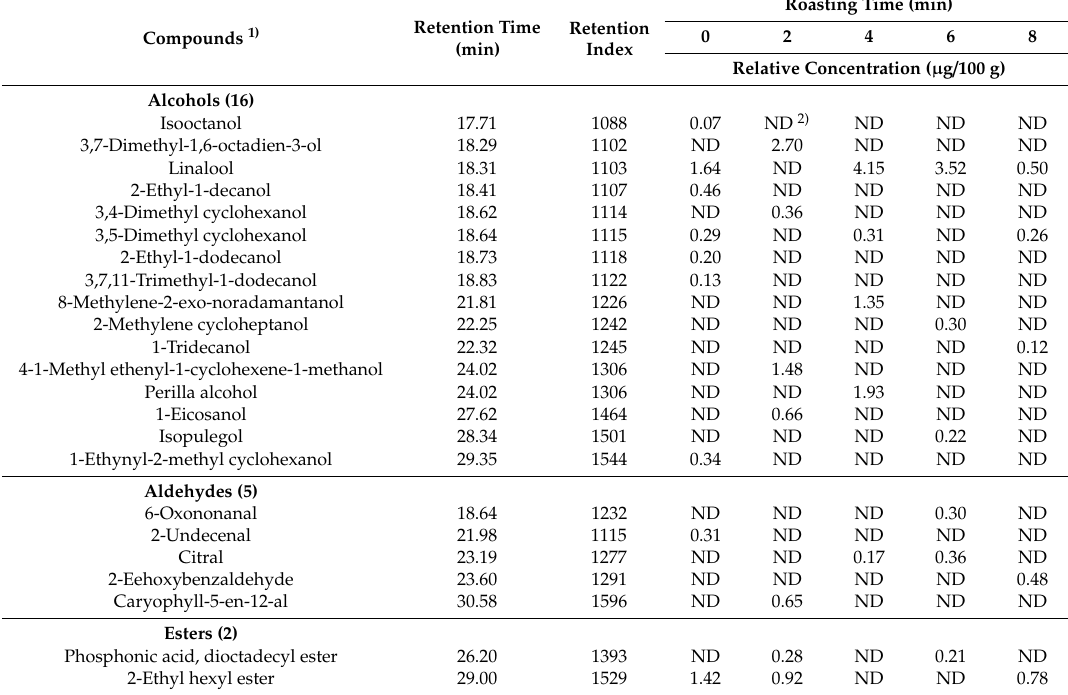
Table 1. Changes in volatile compounds in P. frutescens Britton var. acuta Kudo during the